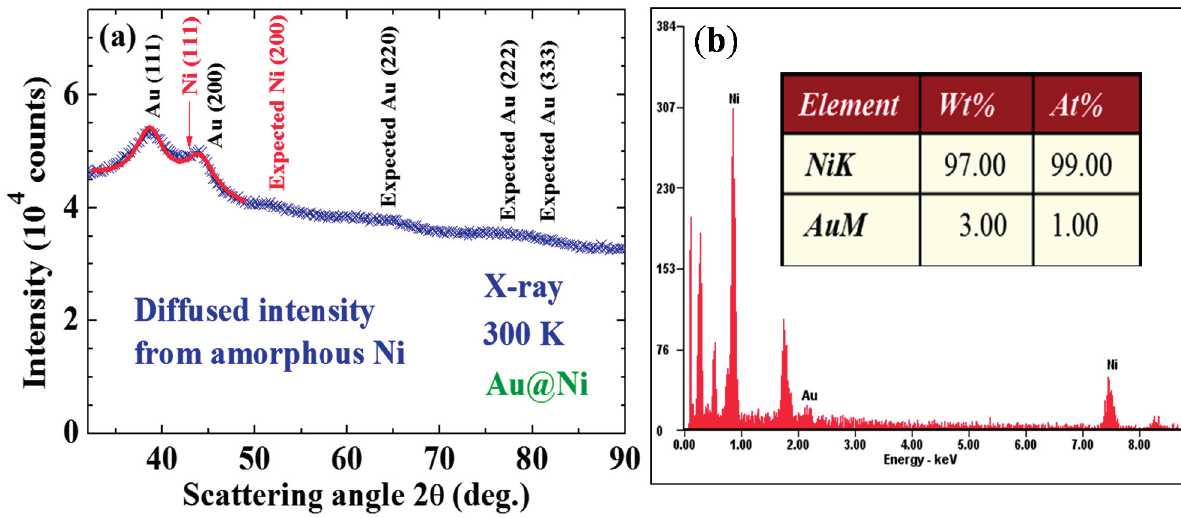
Figure 1. ( a ) X-ray diffraction pattern of the Au@Ni nanoparticles taken at 300 K, revealing a series of diffraction peaks associated with fcc Au together with a strong diffused incoherent intensity distributed over the entire pattern. The arrows indicate the expected peak positions for the fcc Ni. The solid curves indicate the calculated line profiles of the 2.4 nm fcc Au. ( b ) A representative EDXS spectrum, where signals from Au are barely seen but reveal an atomic ratio of Ni:Au = 99:1 for this spatial region of the